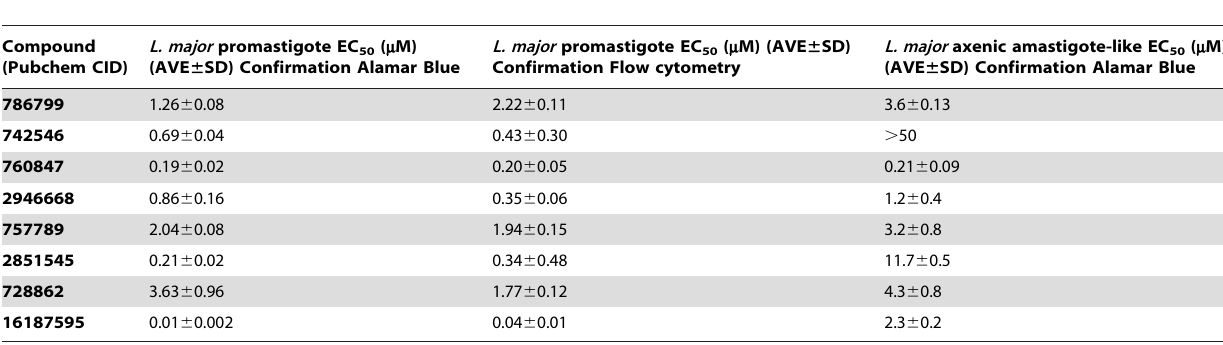
Table 2. Effects of compounds of unknown pharmacological action on L. major promastigotes and axenic amastigote-like populations.